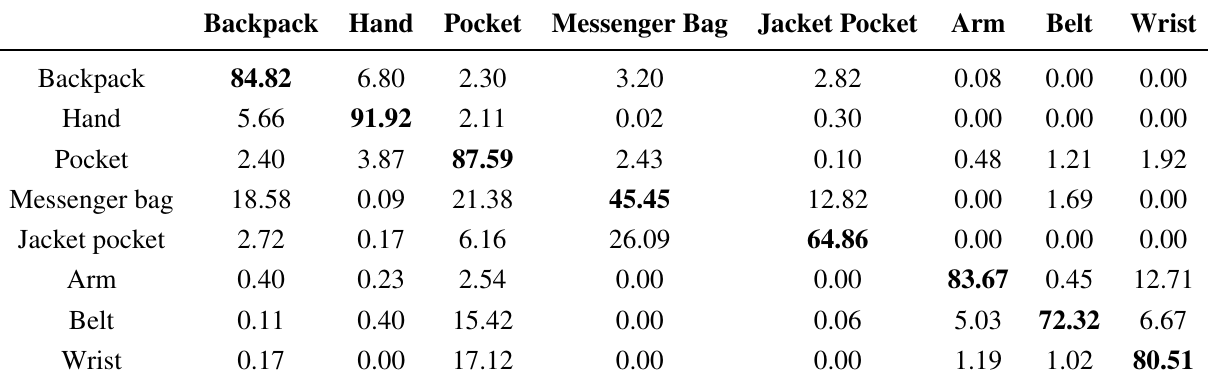
Table 14. Confusion matrices with stationary activities, random forest, in %. Backpack